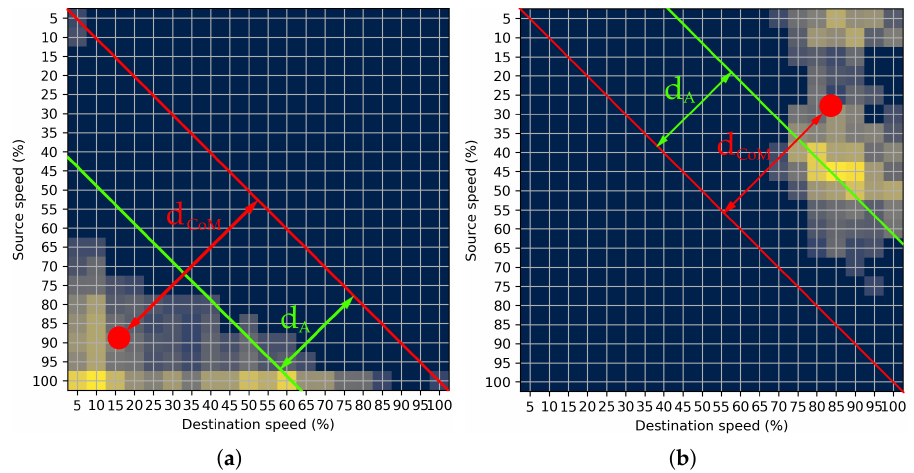
Figure 1. Example of two possible anomaly types: ( a ) Sudden breaks and ( b ) intense accelerations.